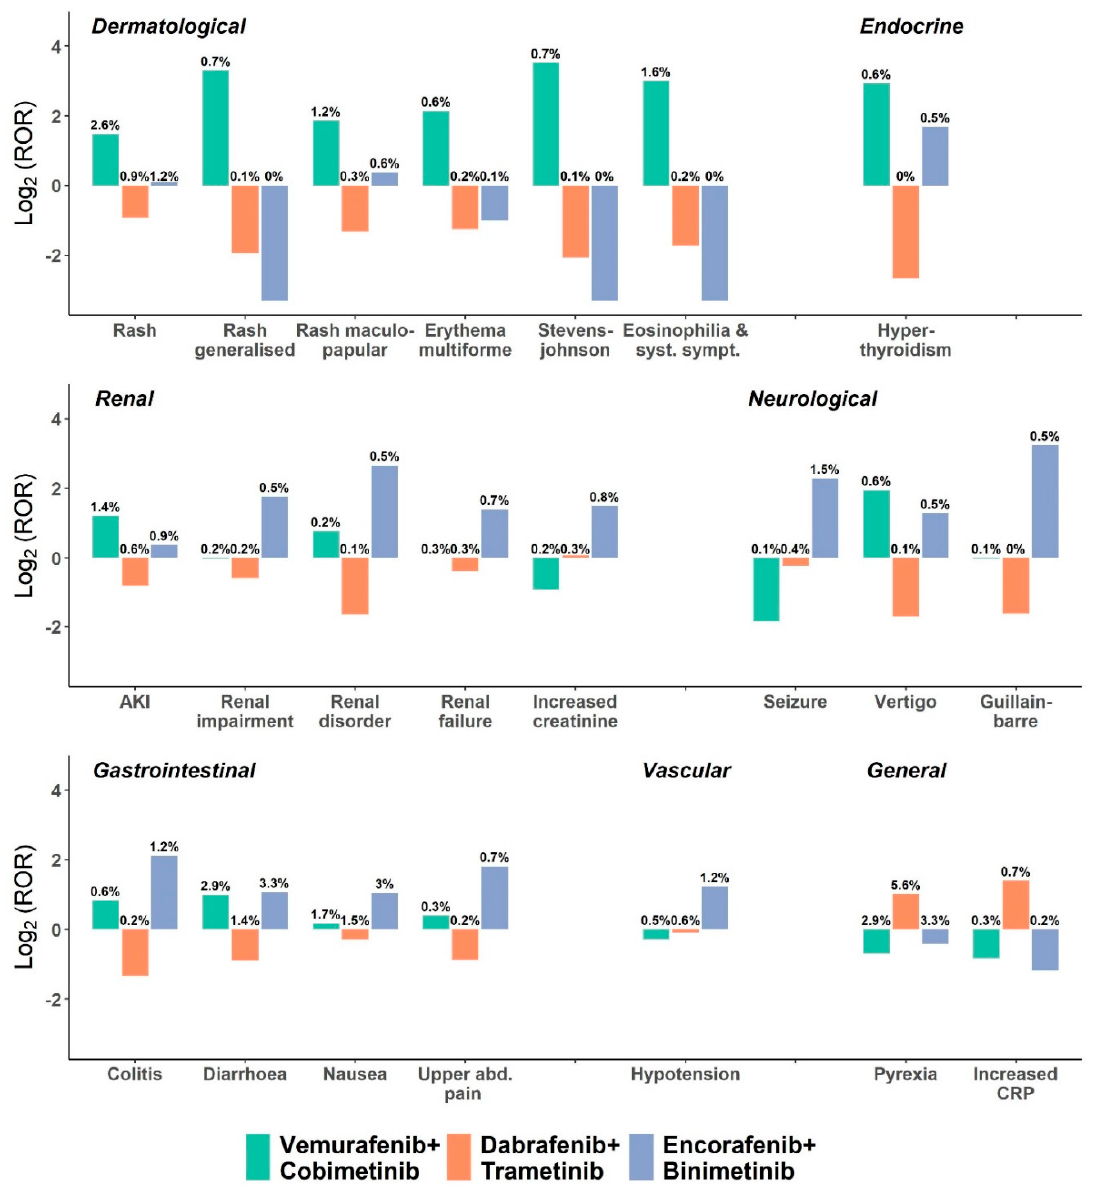
Figure 1. Comparison of serious adverse events (detected as signals) reported for BRAK-MEK inhibitors. The disproportionality analysis included serious adverse events leading to death, life-threatening conditions, disability, or hospitalization from January 2018 to June 2019. Adverse events associated with BRAFi + MEKi as primary or secondary suspects, which were also disproportionally reported compared to the full database, are displayed. The proportion of the events is shown on top of the bars. A constant of 0.1 was added to all ROR values to avoid bias of near zero values. AKI—acute kidney injury. CRP—C-reactive protein.